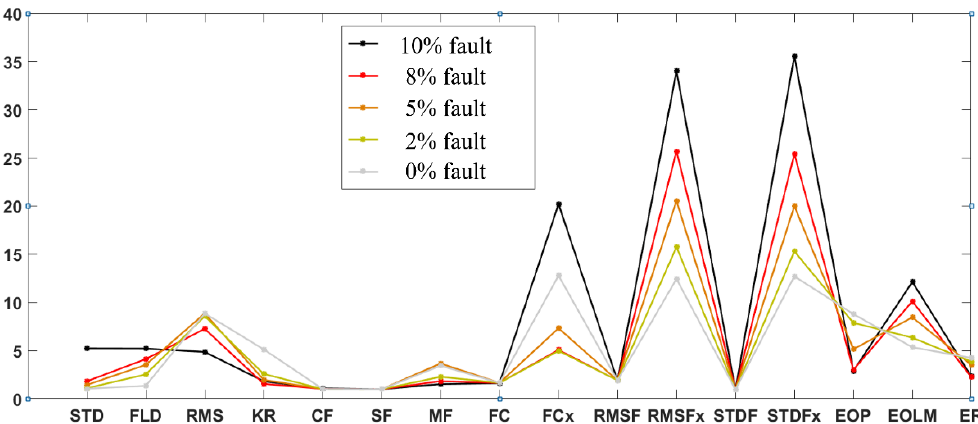
Figure 7. Feature comparison of the control quantity signal for weak fault severity.